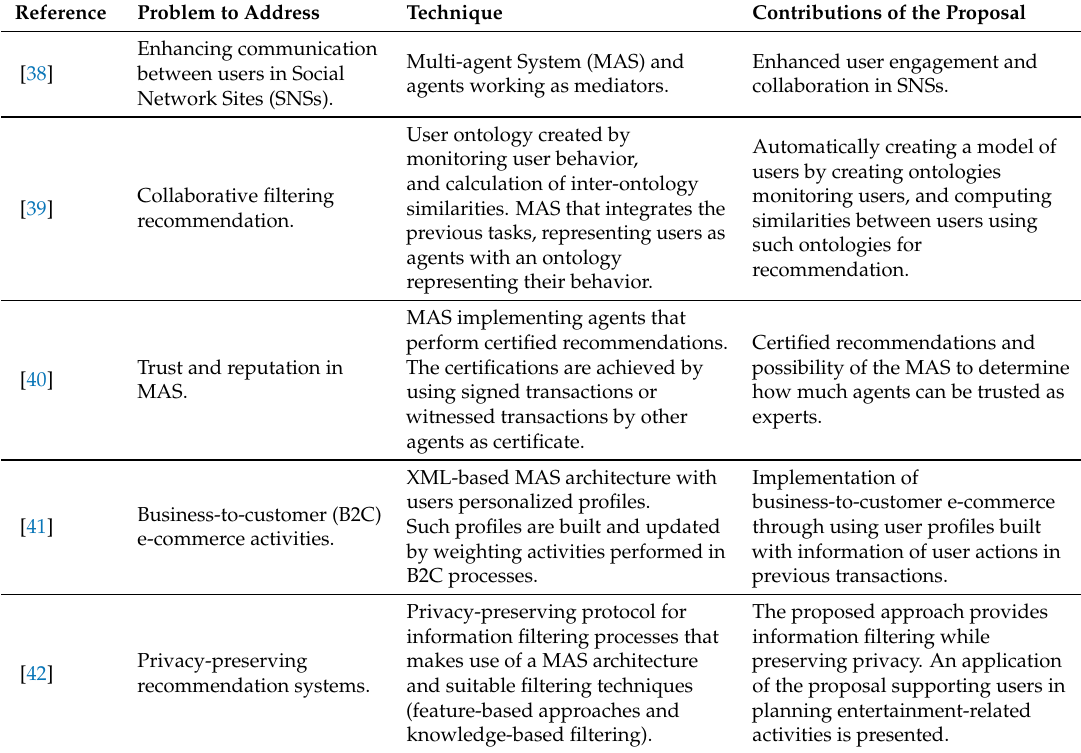
Table 5. Problem addressed, techniques and contributions of the prevention